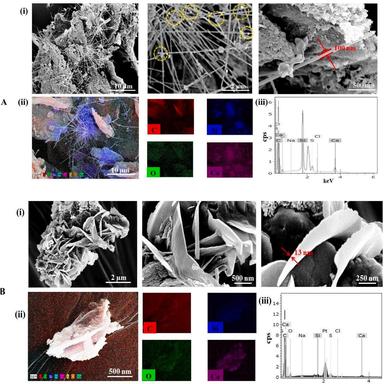
Nano SEM-EDS micrographs indicating the morphological and dimensional properties of SiC NWs arrays (A) and lamellar structures (B). (i) SEM at different magnifications. Remaining biocatalyst droplets at the tip of the NWs are circled in series (A). (ii) Map of elements and individual elements at high-magnification. (iii) Elemental spectral data.